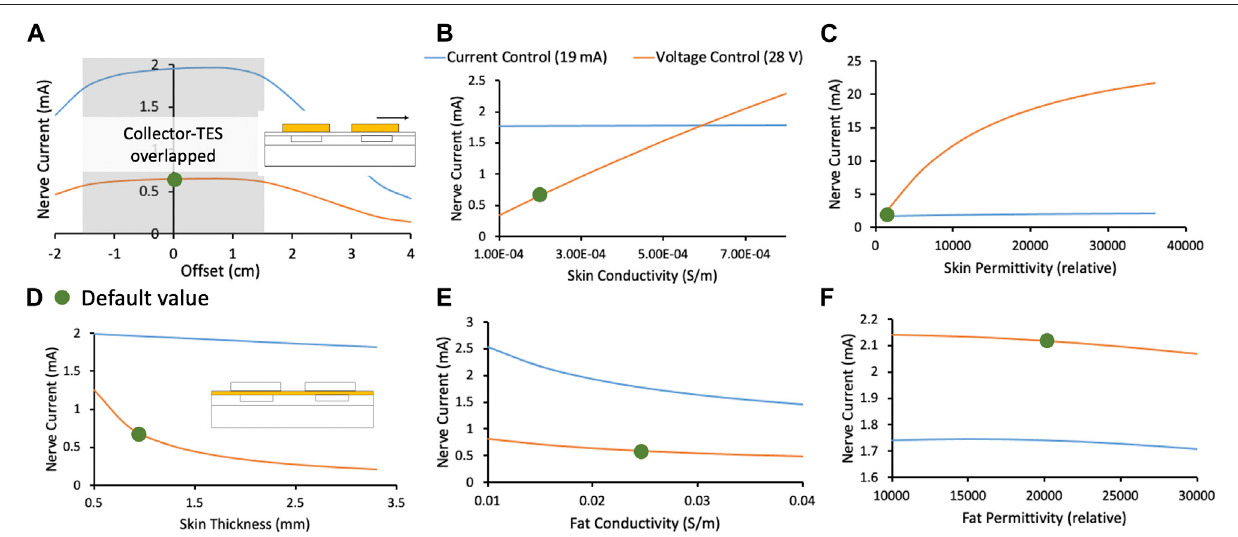
FIGURE 6 | In this fi gure, orange and blue traces represent the deep target nerve current in response to voltage-controlled and current-controlled stimulation, respectively. Green dots denote the default parameters used in the FEM model. (A) Deep target nerve current is stable while the surface electrode completely overlaps the collector. (B) Deep target nerve current is more stable to variations in skin conductivity under current-controlled stimulation relative to voltage-controlled stimulation. (C) Deep target nerve currentismore stable tovariations in skin permittivity under current-controlledstimulationrelative tovoltage-controlled stimulation. (D) Deep target nerve current is more stable to variations in skin thickness under current-controlled stimulation relative to voltage-controlled stimulation. (E) Deep target nerve current is somewhat more stable to variations in fat conductivity under voltage-controlled stimulation relative to current-controlled stimulation. (F) Deep target nerve current is not sensitive to variations in fat